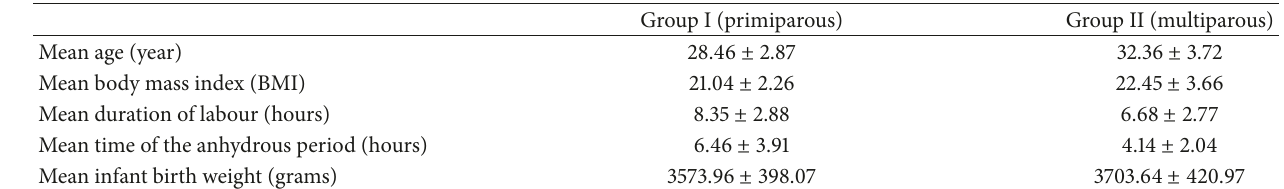
Table 1: Women’s characteristics (mean values ± standard deviation).